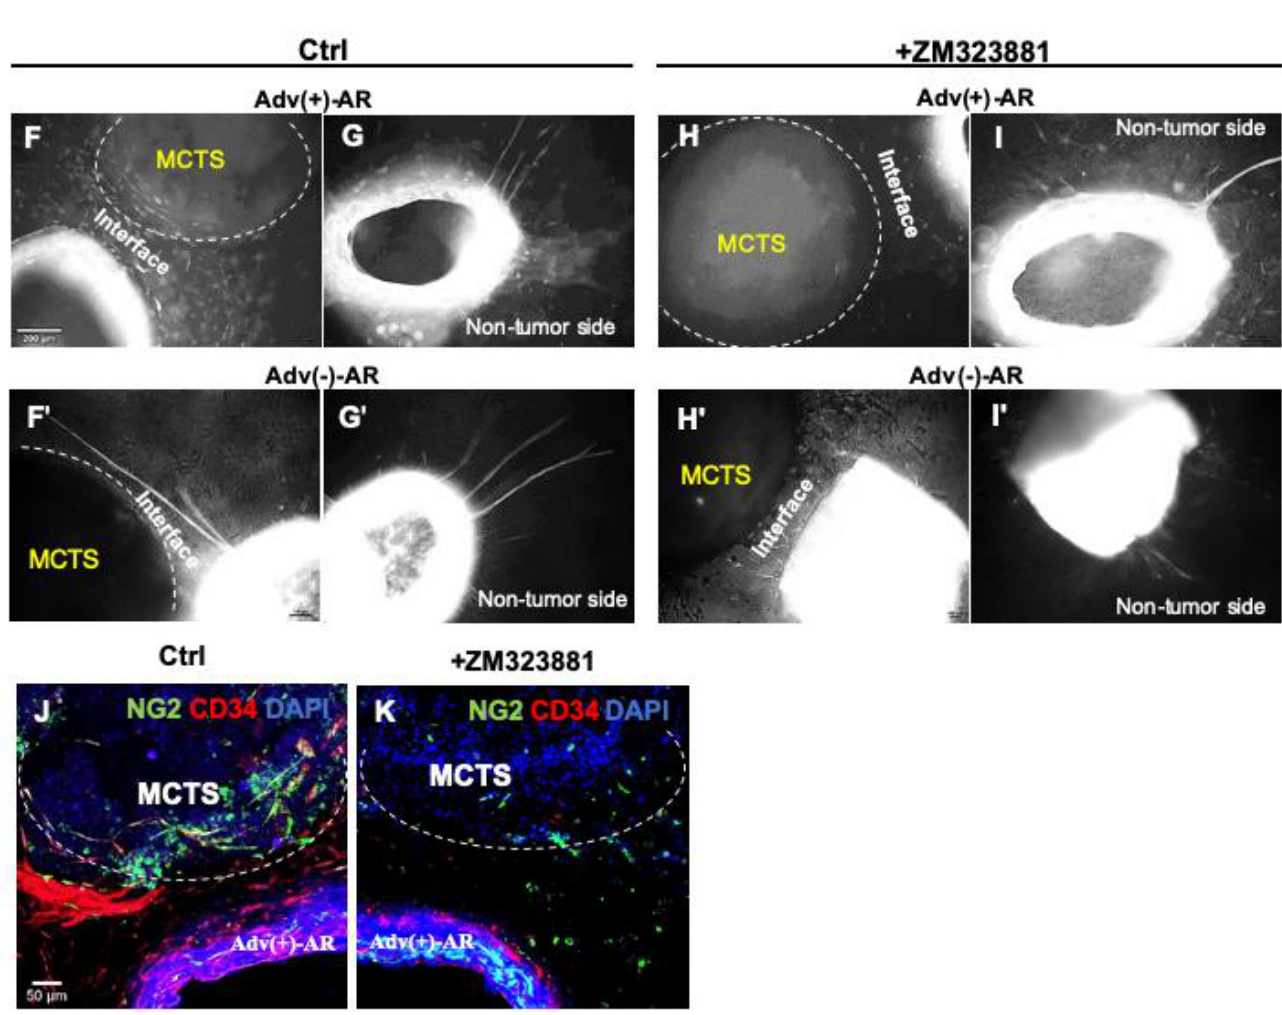
Figure 6. Vascular adventitial cells affect response to VEGF-R inhibition. ZM323881 reduces vascular sprouting less efficiently in ARA with the adventitia in place ( A , B ) than in mdARA ( C , D ). The quantification of sprouting ( E ). Treatment with ZM323881 reduced the migration of cells towards the MCTS in the Adv(+) experiments ( F vs. H ), but had little effect on sprouting at the non-tumor side ( G vs. I ). In the Adv(-) experiments, ZM323881 completely blocked capillary sprouting ( F’ – H’ versus G’ – I’ ). Whole mount staining of CD34 + cell in red and NG2 + cells in green ( J – K ), under hypoxia, at day 14. Error bars indicate SD. * p ≤ 0.05, ** p ≤ 0.01, **** p ≤ 0.0001 .